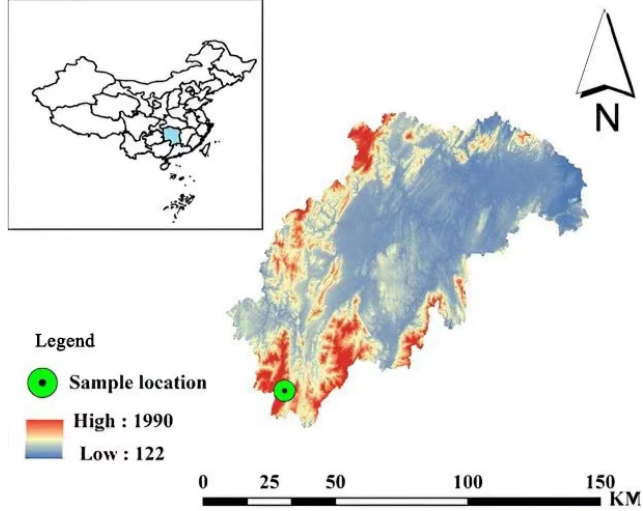
Figure 1. Soil sampling site at Nanshan Pasture, Hunan Province. The inset shows the location of Hunan Province in China. Data Center for Resource and Environmental Sciences, Chinese Academy of Sciences, 2021.